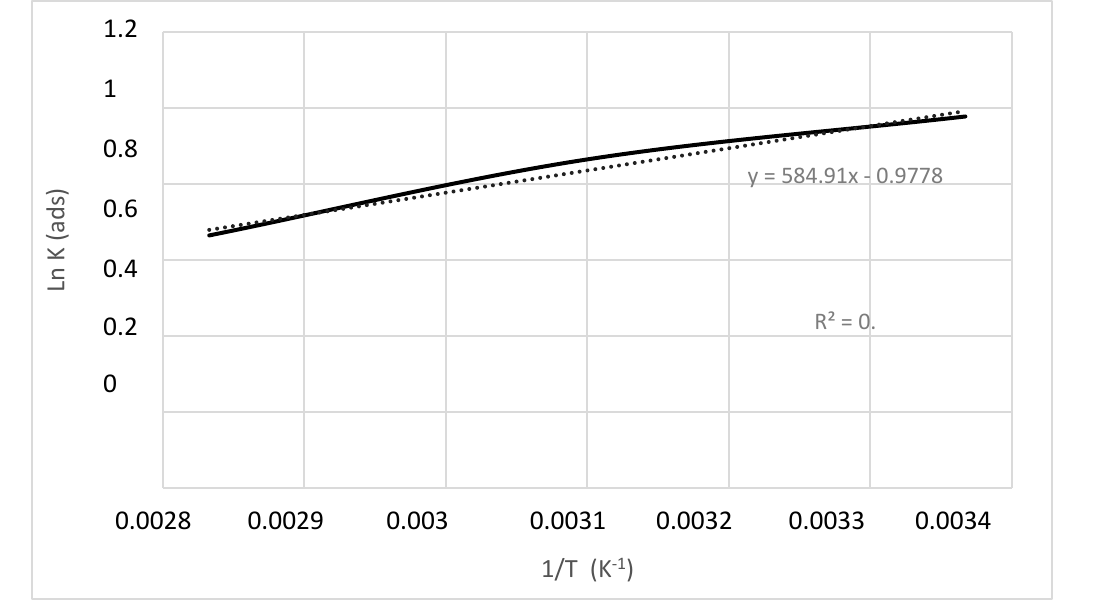
Figure 16. Ln(K ads ) as function of 1/T. Table 7. Thermodynamic parameters for adsorption of BR into ALP. Parameters